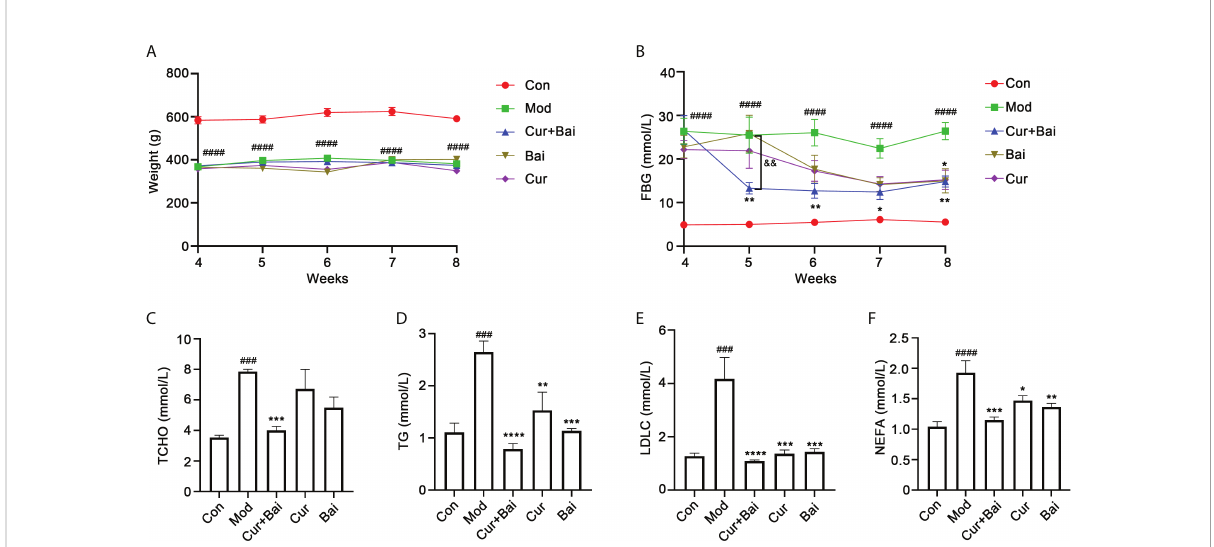
FIGURE 3 Cur+Bai effectively lowered the FBG and blood lipid levels in diabetic rats. (A) The body weights of diabetic model group were constantly lower than that of the control group (n=5 per group). The treatments of Cur+Bai, Cur or Bai did not change body weight from week 4 to week 8 compared to that of the diabetic model group. #### p <0.0001 vs. control group. (B) . Cur+Bai, Cur and Bai time-dependently reversed the HFD- induced high FBG level (mmol/L) in diabetic group (n=5 per group) from week 4 to week 8. The FBG lowering effect in the Cur+Bai was greater than that of Cur or Bai group from week 5 to week 7. #### p <0.0001 vs. Con at the same time point. * p <0.05, ** p <0.01 vs. Mod at the same time point. && p <0.01, Cur+Bai vs. Bai compared at the same time point. The changes of blood lipid levels by Cur+Bai, Cur and Bai in the diabetic rats, including TCHO (C) , TG (D) , LDLC (E) and NEFA (F) with n=5 per group. ### p <0.001, #### p <0.0001 vs. Con at the same time point. * p <0.05, ** p <0.01, *** p <0.001, **** p <0.0001 vs. Mod at the same time point. Results were expressed as mean ± SEM for fi ve rats per group. The p values were obtained from one-way ANOVA